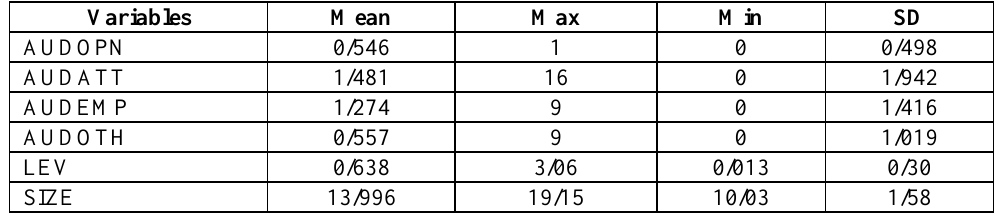
Table 1. Descriptive Statistics of Research